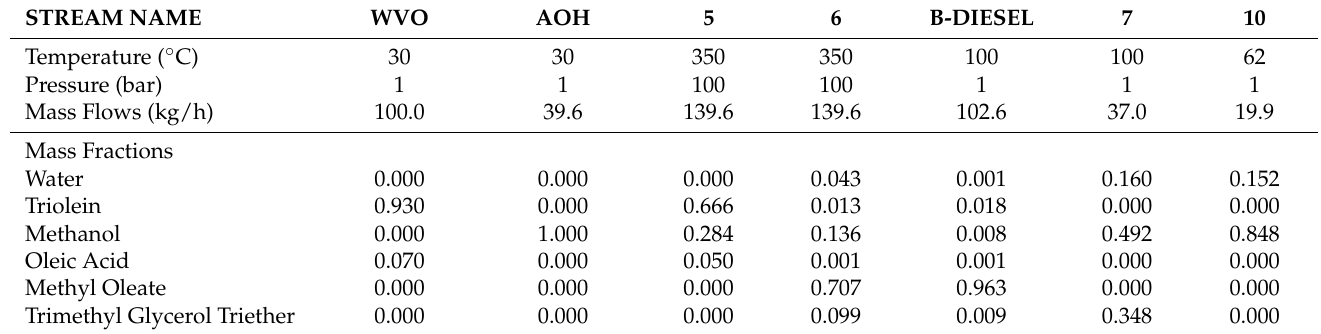
Table 3. Operating conditions and mass compositions of simulation streams. Supercritical Process.